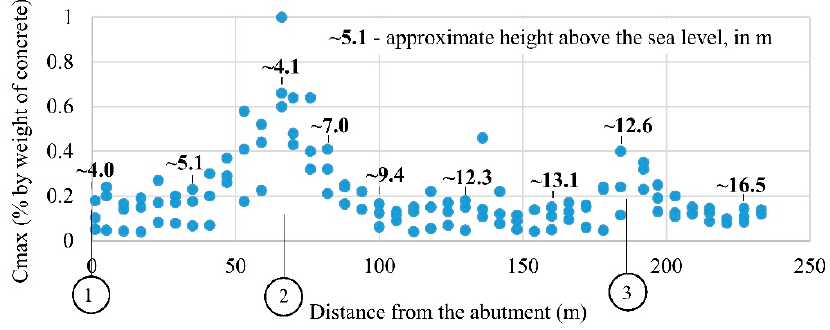
Figure 11. Chloride concentrations C max in Gimsøystraumen Bridge measured in a 10 mm thick concrete layer after 11 years of exposure to Norwegian coastal climate [59].